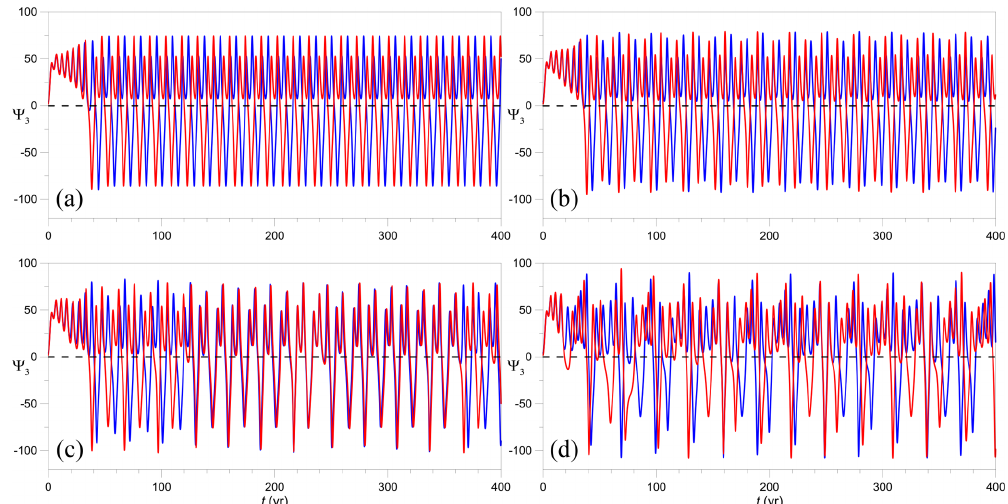
Figure 9. Increasing instability of trajectories as ε increases. Time evolution of (cid:57) 3 (t) for the trajectory initialized at the point P 2 (red line) and at a nearby point (blue line) for γ = 1 . 1, T p = 30 years, and (a–d) ε = 0 , 0 . 05 , 0 . 1 and 0 .